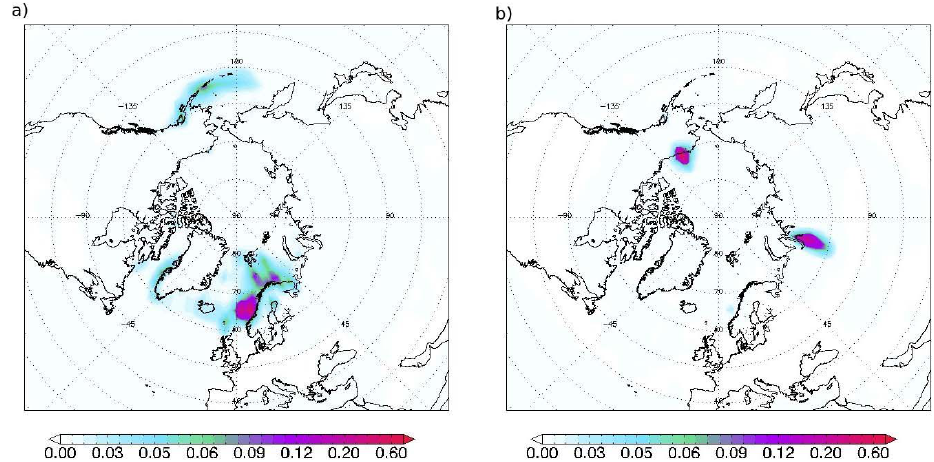
Fig. 2. Yearly average contribution to NO x [ppb] in the lowest 1.5km of the troposphere from (a) shipping activity and (b) petroleum activity in 2004.